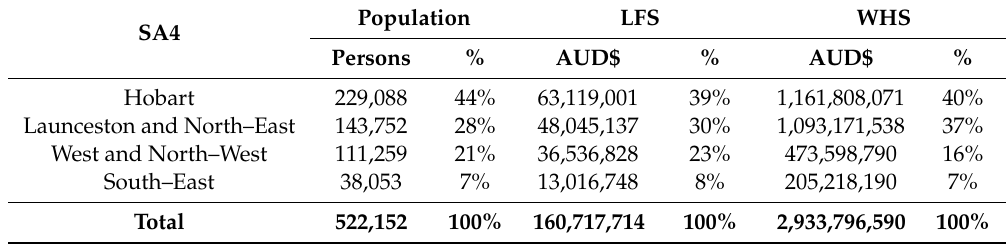
Table 6. Estimated population (2017) and total costs by source type and region